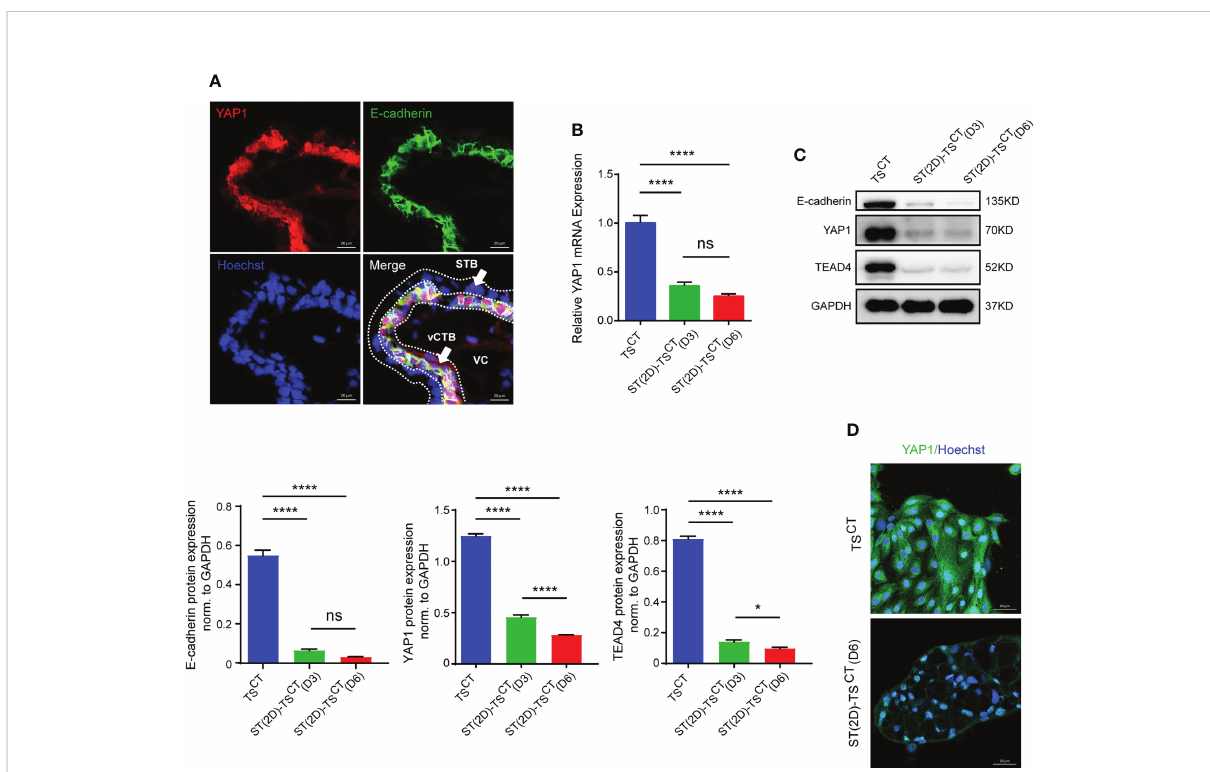
FIGURE 5 YAP1 and TEAD4 expression is decreased during trophoblast cell syncytialization in vitro . (A) Immuno fl uorescence staining of YAP1 (red), E- cadherin (green) and Hoechst staining (blue) in human healthy placentas (sixth to eighth week of gestation). White arrows indicate CTBs and STB, respectively. VC, villous core. Representative images from three independent experiments are shown. Scale bar, 20 m m. (B) Quanti fi cation of YAP1 mRNA expression. The mean values ± SEMs (normalized to GAPDH ) of human TS CT , ST(2D)-TS CT (D3) and ST(2D)-TS CT (D6) cell cultures, as measured in duplicate, are shown. **** p <0.0001; ns: p =0.1255. (C) Representative Western blotting of E-cadherin, YAP1, and TEAD4 expression in TS CT and ST(2D)-TS CT cells (D3 and D6). Semiquantitative analysis of E-cadherin, YAP1, and TEAD4 protein expression normalized to GAPDH (n=3). * p =0.0185; **** p <0.0001; ns: p =0.1220. (D) Immuno fl uorescence staining of YAP1 (green) and Hoechst staining (blue) in human TS CT and ST(2D)-TS CT cells (D6). Scale bar, 50 m